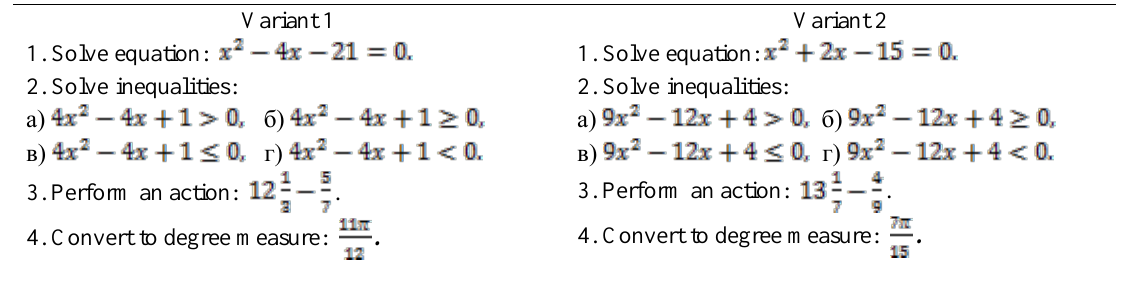
Table 1. Mathematical part of